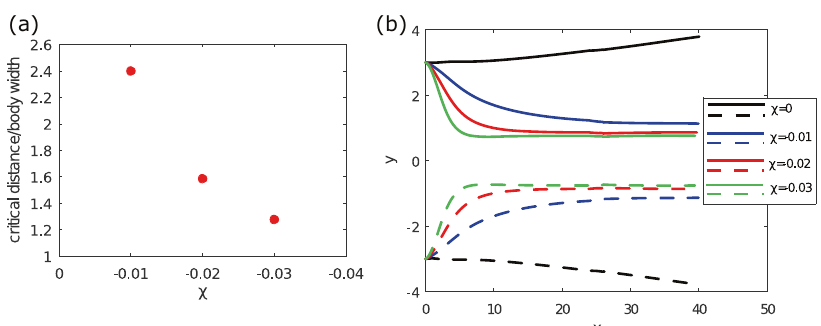
Fig. 5 Two parallel swimmers. Two pushers ( β = − 2) with planar anchoring ( W = 0.5) swim with parallel initial velocities. The initial distance from the side to side is 8 times larger than their widths. a Critical distance (measured from side to side) between two swimmers when they resume traveling in parallel. b Trajectories of the centers of mass of swimmers for different values of χ . The solid curves correspond to the top swimmer, and the dashed curves represent the trajectory of the bottom swimmer.